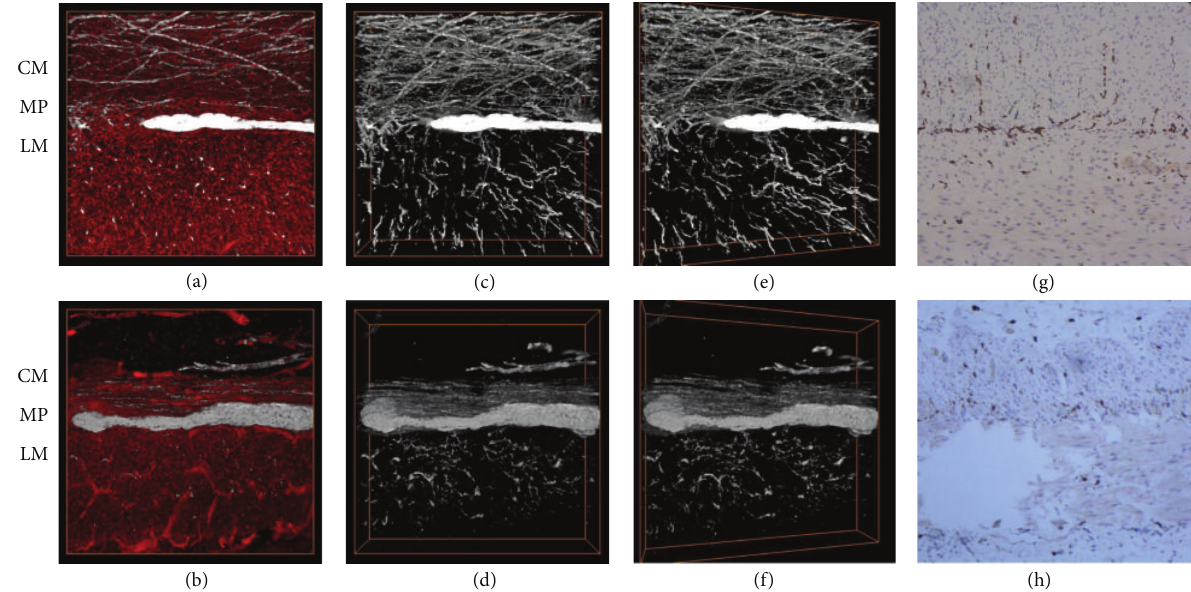
Figure 6: C-kit staining of interstitial cells of Cajal in the donor and recipient intestinal tissues from a MMIHS patient that received intestinal transplantation. ((a) and (b)) Propidium iodide and C-kit staining in the donor (a) and recipient (b) intestinal tissues. ((c) and (d)) C- kit staining in the donor (c) and recipient (d) intestinal tissues. ((e) and (f)) C-kit staining in the donor (e) and recipient (f) intestinal tissues, 15 degree-oblique images of ((c) and (d)). ((g) and (h)) C-kit immunohistochemical studies of the intestinal tissues reconstituted from fluorescence staining. ((g), donor; (h), recipient, 100x). CM: circular muscle layer; MP: myenteric plexus; LM: longitudinal muscle layer. Bar: 100 𝜇